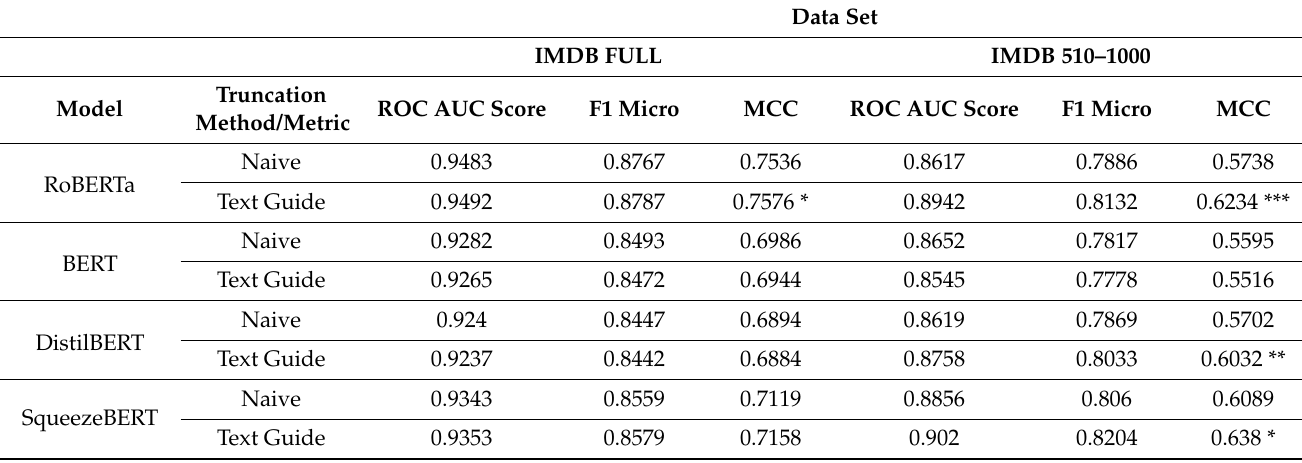
Table 7. Experiments performed with selected pre-trained transformer models on IMDB data sets. For both data sets and all models, the adopted parameters for Text Guide were: XGBoost feature importance as the feature importance method, OLT = 1, all occurrences of important tokens were taken into consideration, the part of the beginning of the original text instance used by Text Guide = 0.1, the part of the ending of the original text instance used by Text Guide = 0, number of tokens surrounding the important token to be used for creating the pseudo sentence = 2.